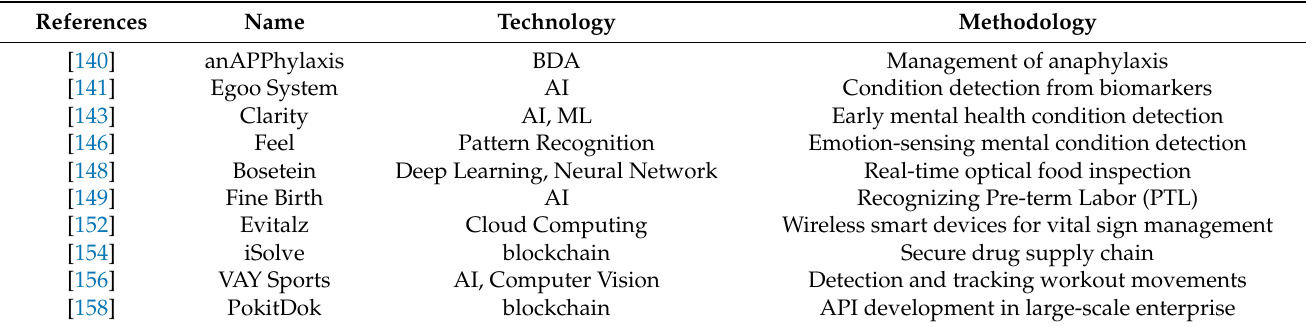
Table 2. Startups having an impact on Healthcare